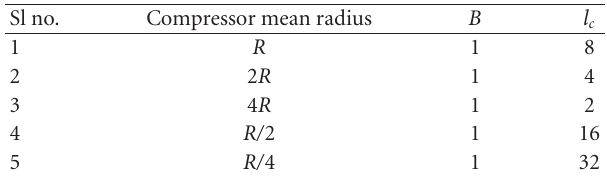
Table 3: Di ff erent compressor mean annulus areas with respect to B = 1 and l c = 8 case. Sl